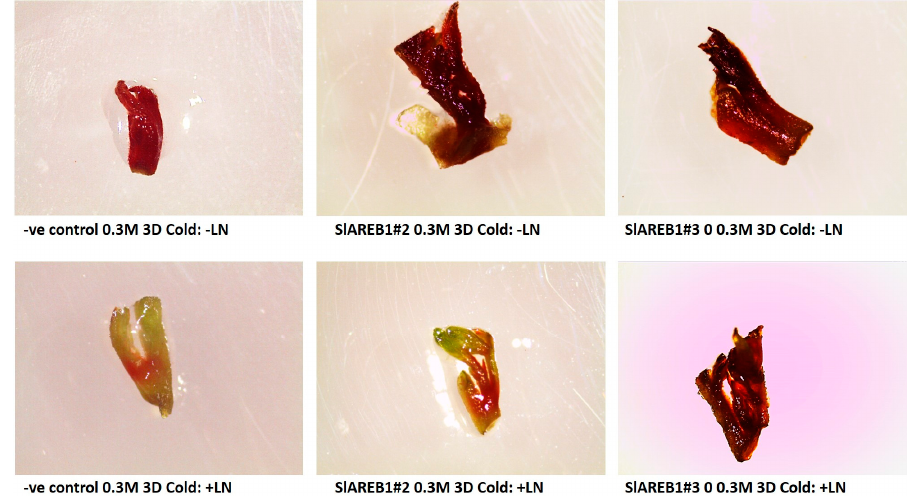
Figure 7. Survival of two transgenic lines overexpressing SlAREB1 (SlAREB1#2 and SlAREB1#3) and negative control (-ve control) after V-cryoplates treatment of 3 day incubation in 0.3 M sucrose and cold acclimatization for 4 days with (+LN) or without liquid nitrogen ( − LN).